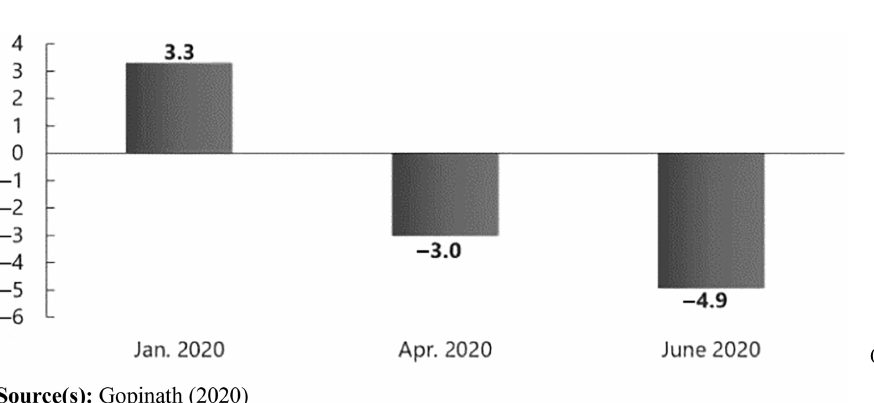
Figure 1. Global GDP output